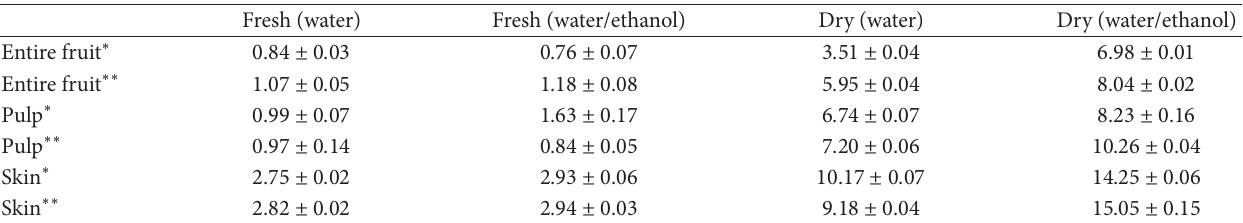
Table 1: Phenolic content of water extracts and 50% aqueous ethanol extracts of fresh and dry entire eggplant, pulp, and skin at 100 ∘ C for 15min, with conventional method or microwave-assisted extraction (MAE). Values are reported in mg gallic acid equivalents ± SD ( 𝑛 = 3 ) on 1.5 g of eggplant.